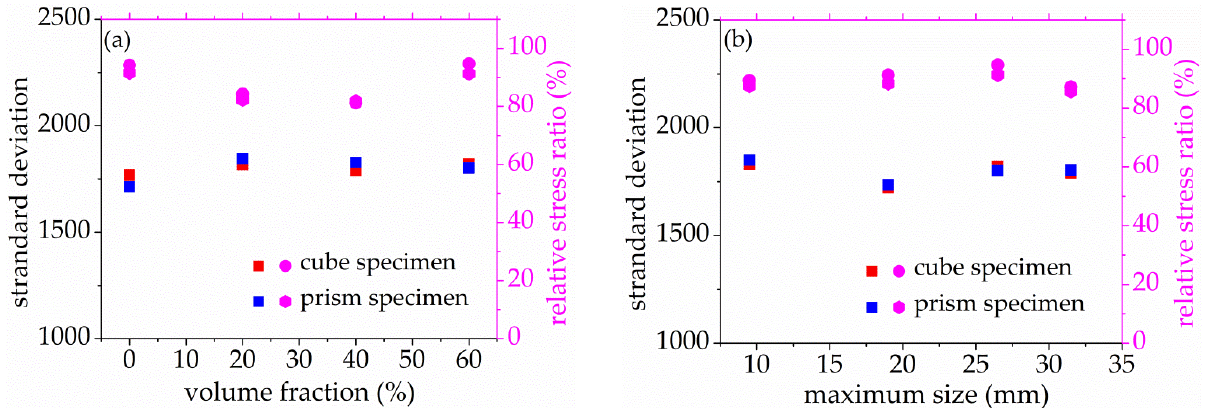
Figure 20. Standard deviation of acoustic emission penetrating wave velocity of concrete with different mix proportion at peak point, ( a ) volume fraction, ( b ) maximum